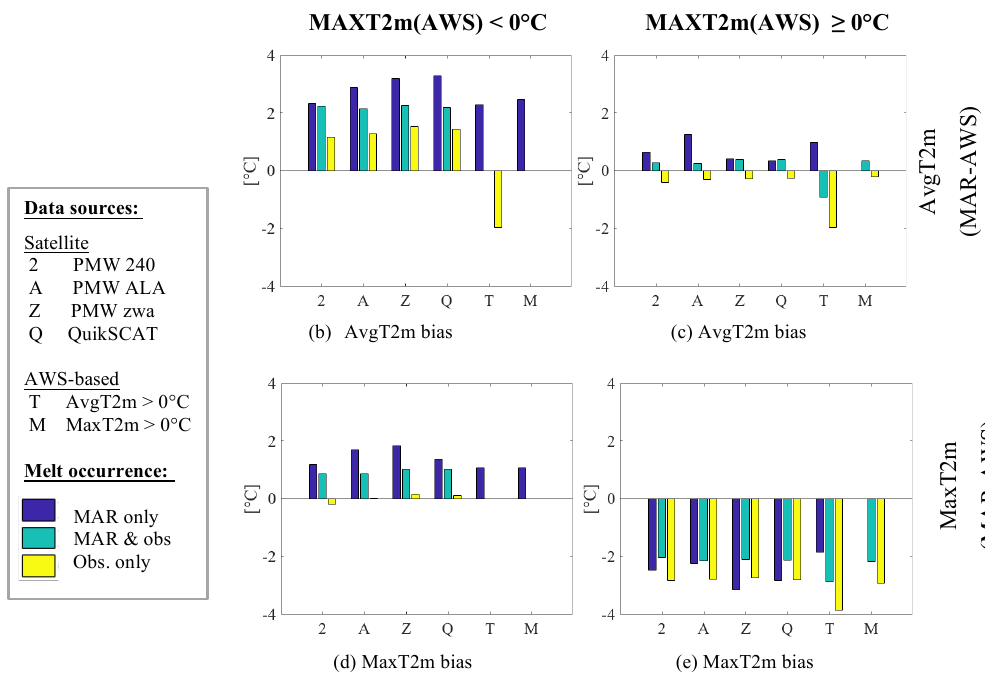
Figure 4. Melt occurrence and temperature biases at the Larsen Ice Shelf AWS Station. Percentage of total days (DJF, 2001–2010) showing melt occurrence from observational sources as compared to MAR v3.5.3 melt occurrence using the MF 0 . 4 metric (a) . Temperature biases (MAR-AWS) for AvgT2m (b, c) and MaxT2m (d, e) , when Max T2m is less than 0 ◦ C (b, d) or greater than 0 ◦ C (c, e)